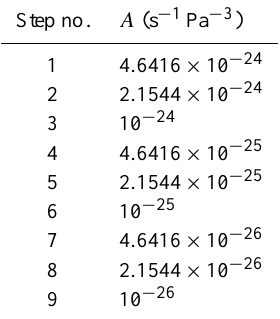
Table 3. Values of A used in EXP